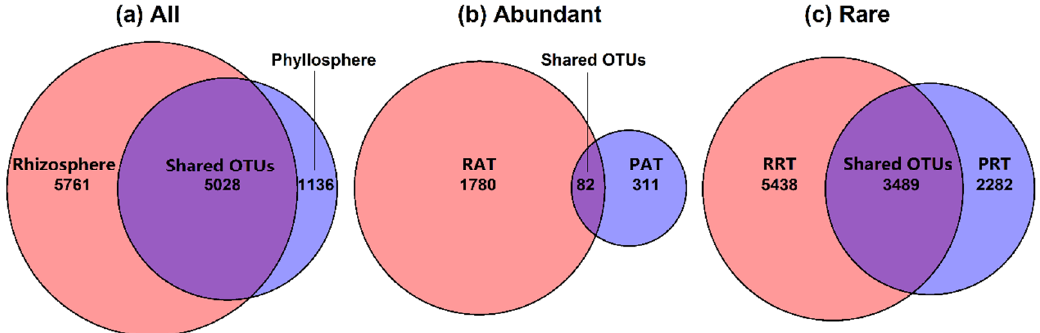
Figure 4. Venn diagram showing the numbers of unique and shared operating taxonomic units (OTUs) across different groups. ( a ) All, whole bacteria taxa; ( b ) Abundant, abundant bacteria taxa; ( c ) Rare, rare bacteria taxa. RAT, rhizosphere abundant taxa; PAT, phyllosphere abundant taxa; RRT, rhizosphere rare taxa; PRT, phyllosphere rare taxa.